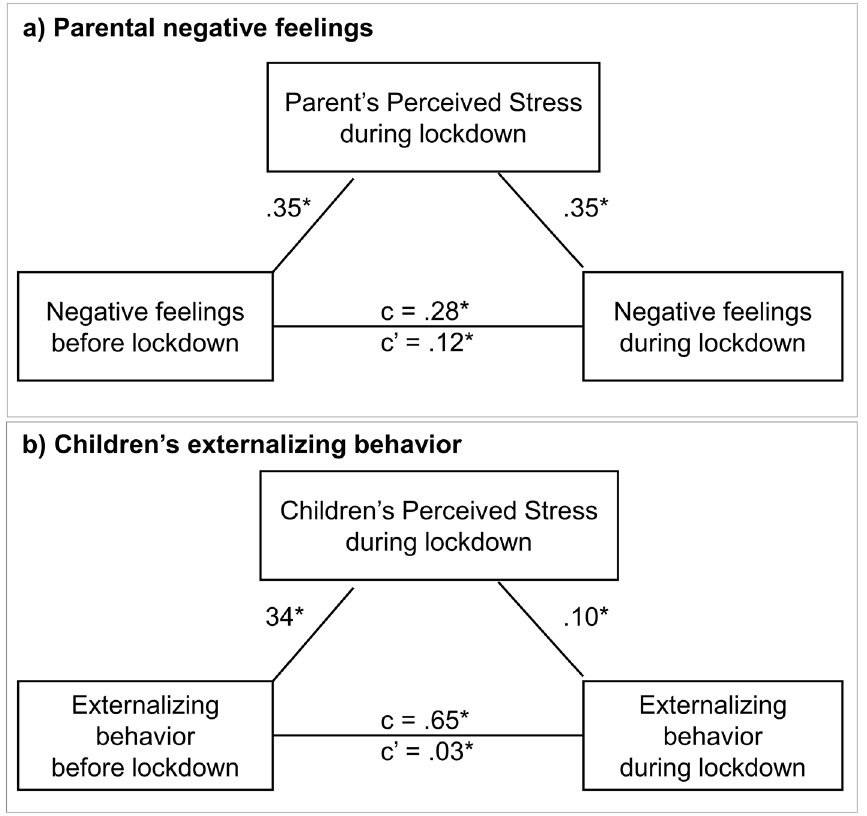
Figure 4. Perceived stress as mediator for longitudinal changes in parental negative feelings ( a ) and externalizing behavior in children ( b